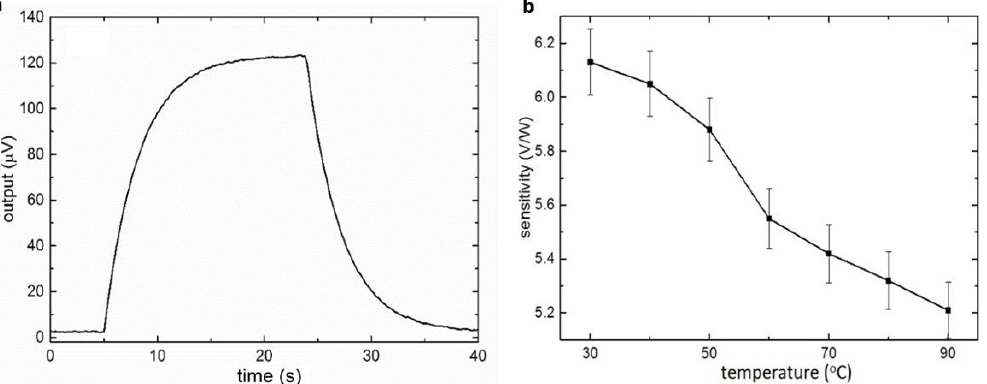
Figure 2. The sensitivity characterization of the MEMS DSC. ( a ) Step response of the MEMS-based DSC (20 µ W input, 30 ◦ C). ( b ) Relationship between the sensitivity and the temperature (error bars represent the stand errors of the